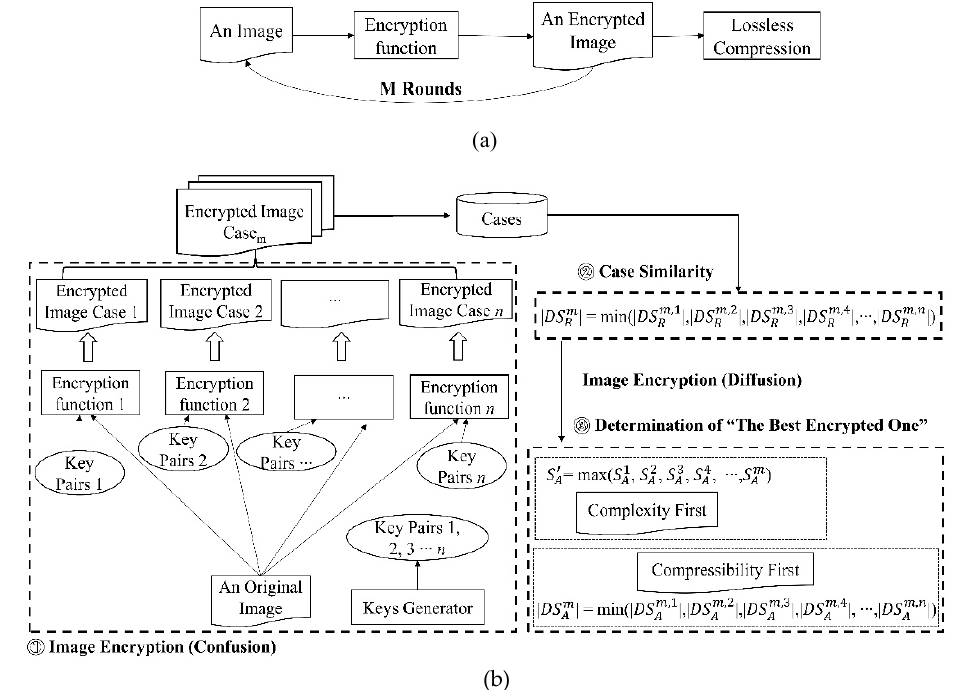
Figure 5. The schematic process of the proposed encryption function. ( a ) Encryption of a DEM (an image) for m rounds. ( b ) Determination of the best encrypted one with configurational entropy; m ( ≥ 1) represents the m total encryption rounds; n ( ≥ 1) represents the number of scrambled images with respect to 2 n key pairs for generating logistic maps.